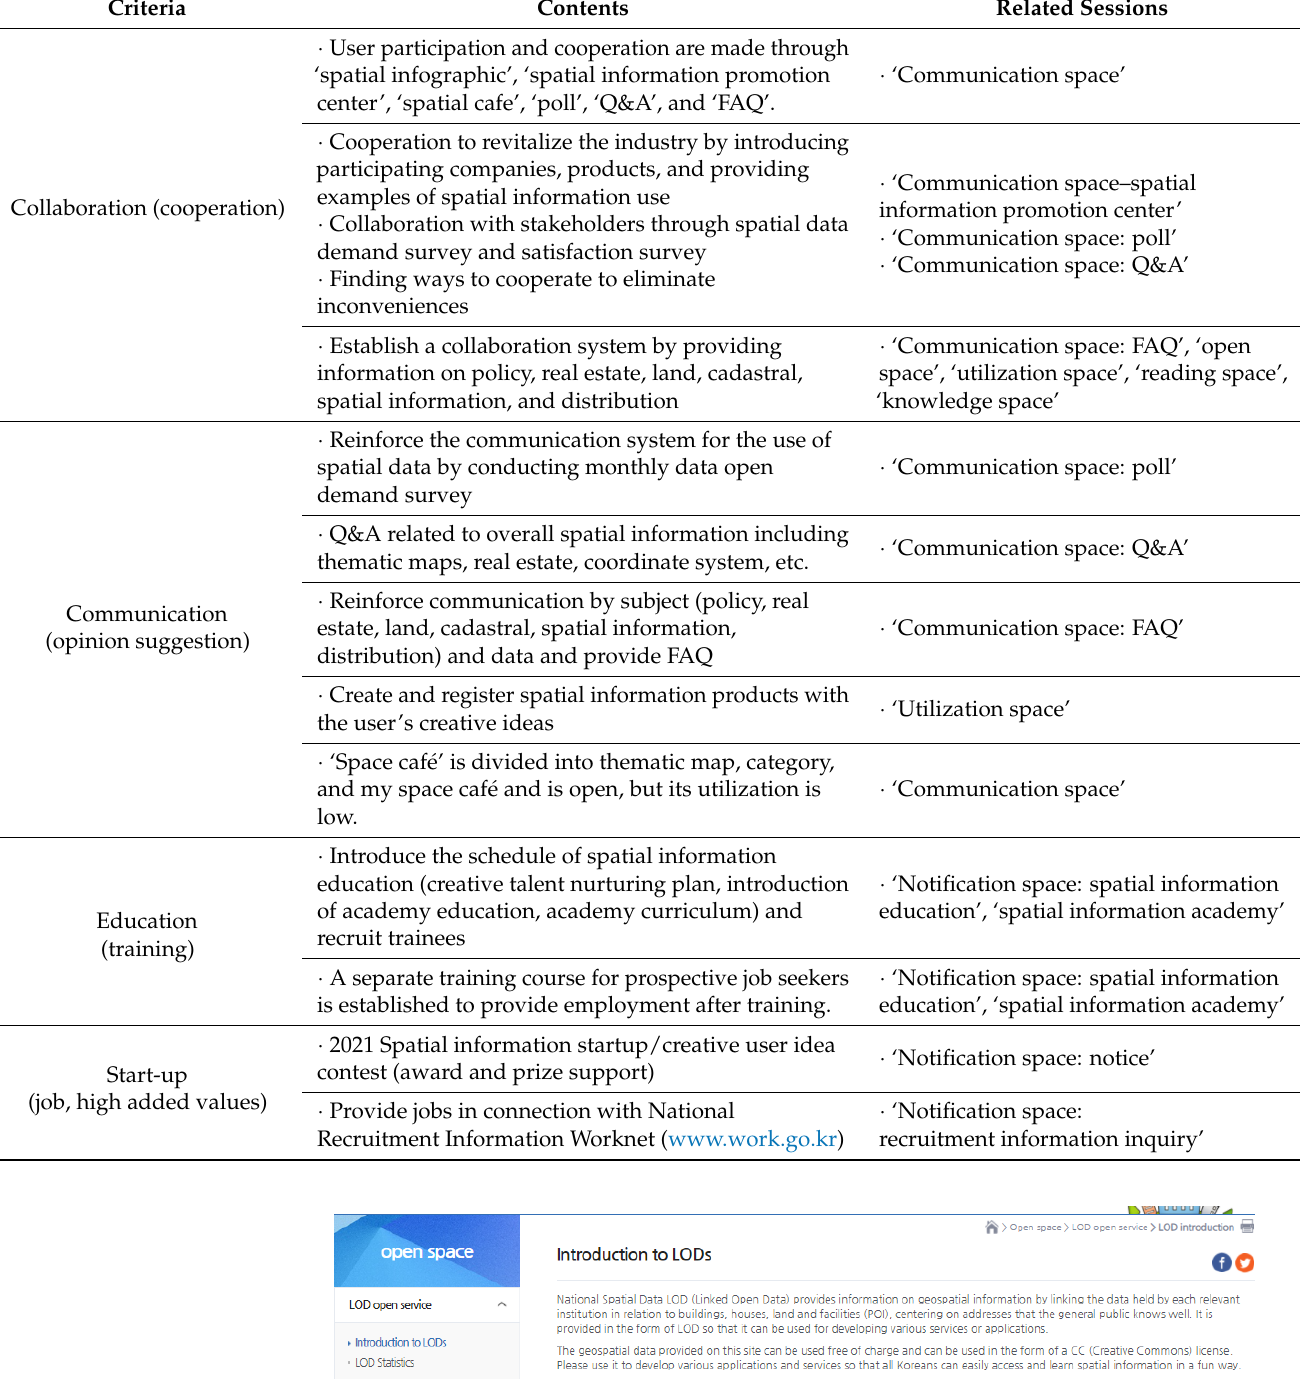
Table 3. Evaluation of stakeholder participation in NSDIP.